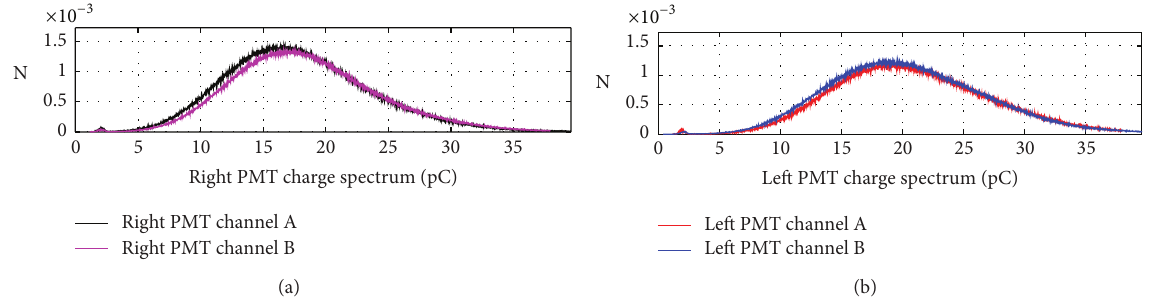
Figure 6: Charge spectra for the Right PMT (a) and for the Left PMT (b) obtained by injecting the UV laser into the center of the fiber ribbon and reversing the electronic chains.